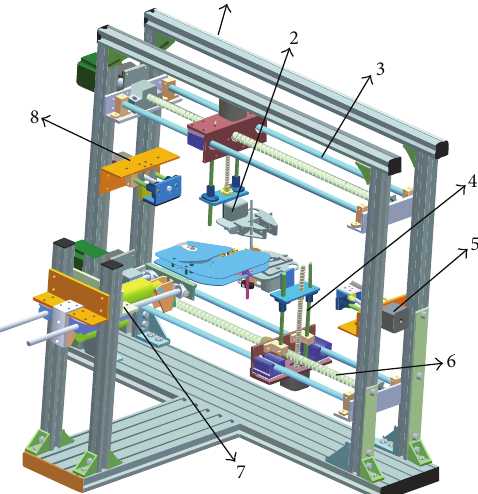
Figure5:Thewholemechanicalstructureofgraftingrobot.1:frame, 2: scion clipping robot hand, 3: scion moving mechanism, 4: stock clipping robot hand, 5: stock cutting mechanism, 6: scion moving mechanism,7:bindingmechanism,and8:scioncuttingmechanism.